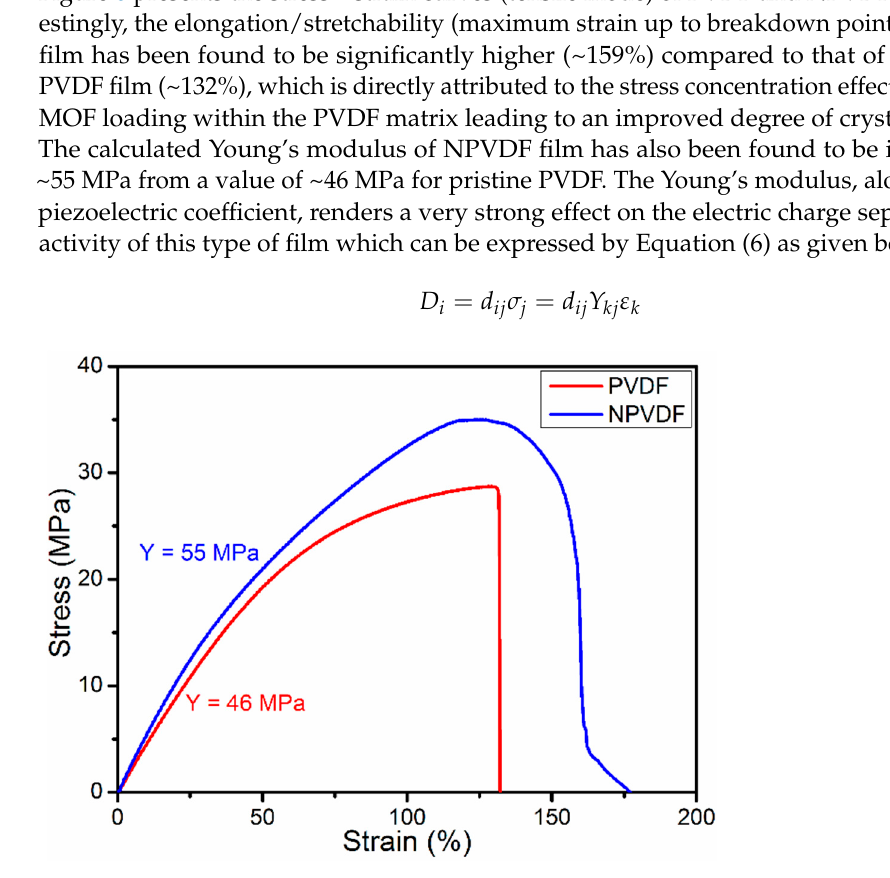
Figure 6. Stress-strain curves of PVDF and NPVDF fi